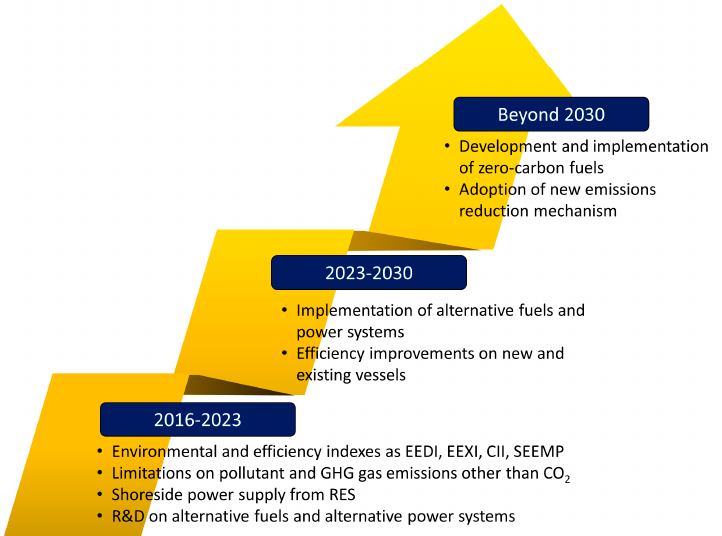
Figure 1. Timeline of IMO strategies for reducing shipping emissions. Information retrieved from [3].